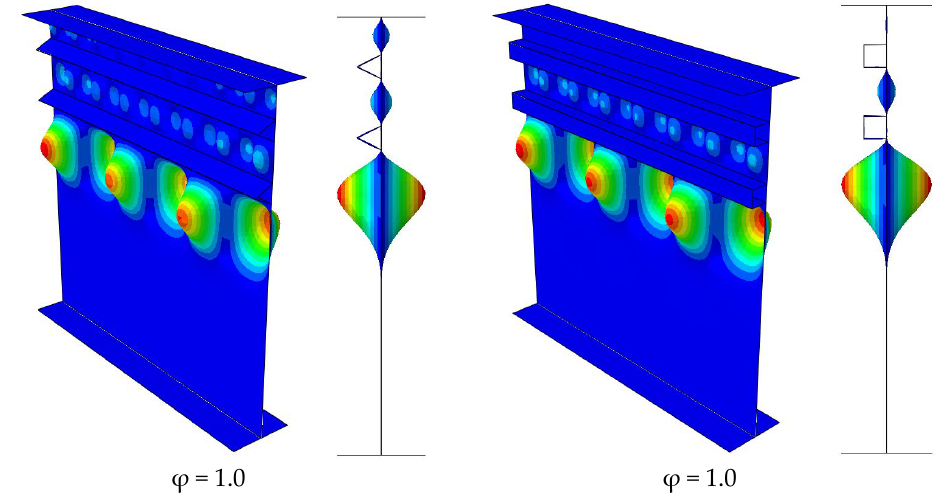
φ = 1.0 Figure 8. Bend-buckling mode shapes of a stiffened girder with triangular and rectangular stiffener cross-sections.